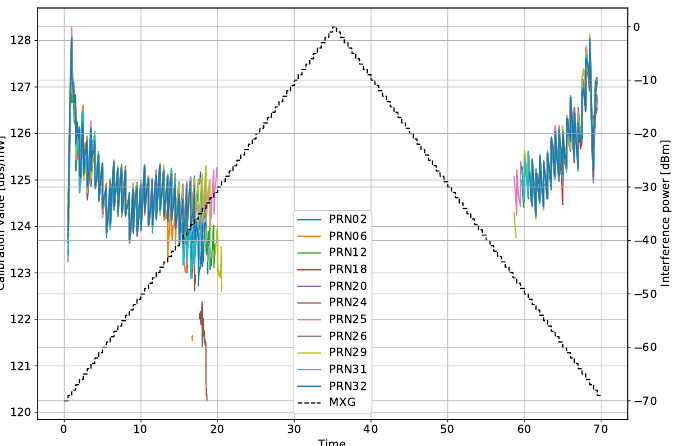
Figure 6. Estimated I / N 0 from the 4MHz bandwidth filtered noise interference scenario.